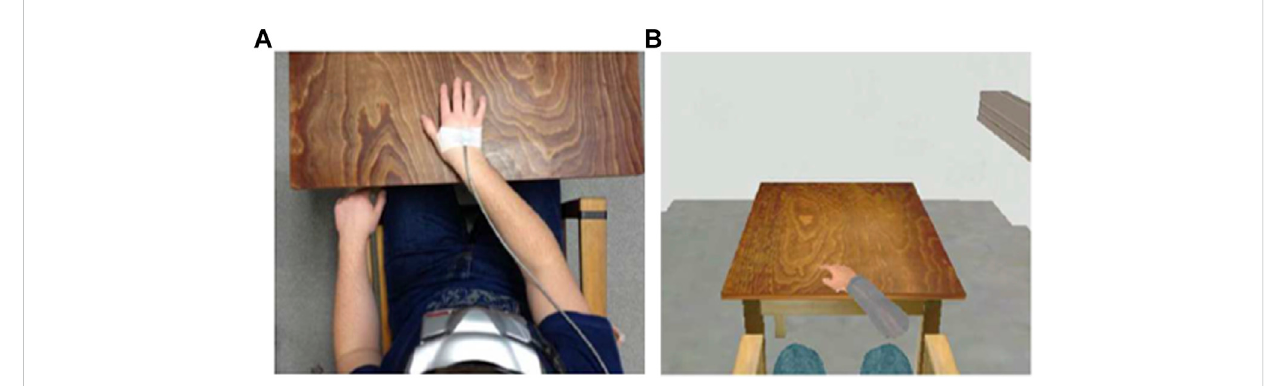
FIGURE 1 Laboratory setup and corresponding VR scenario. (A) Laboratory setup, including head-mounted display (HMD) and hand tracking. (B) VR scenarios including VR hands. Pictures are adapted from our previous study (Peperkorn et al.,